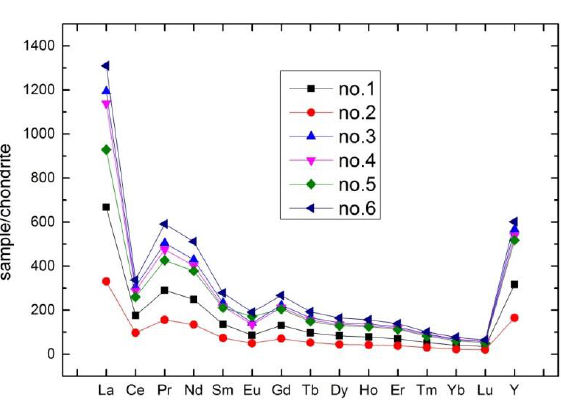
Figure 4. Normalized rare earth elements (REE) patterns of phosphorite samples (after Boynton, 1984 [30]).